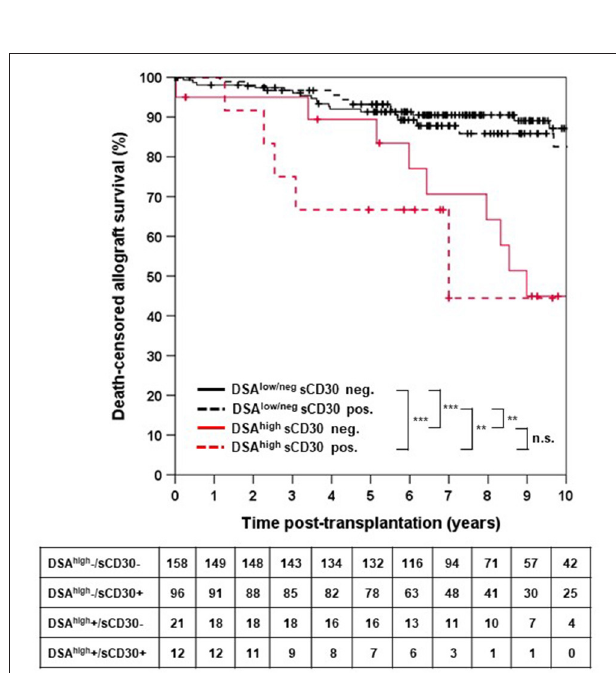
FIGURE 2 | Death-censored allograft survival stratified by DSA high and sCD30 status. DSA high were defined as DSA with an MFI ≥ 5,000. DSA low / neg indicates either no DSA or DSA with MFI between 500 and 5,000. *** p < 0.001, ** p < 0.01, and n.s. = non-significant.